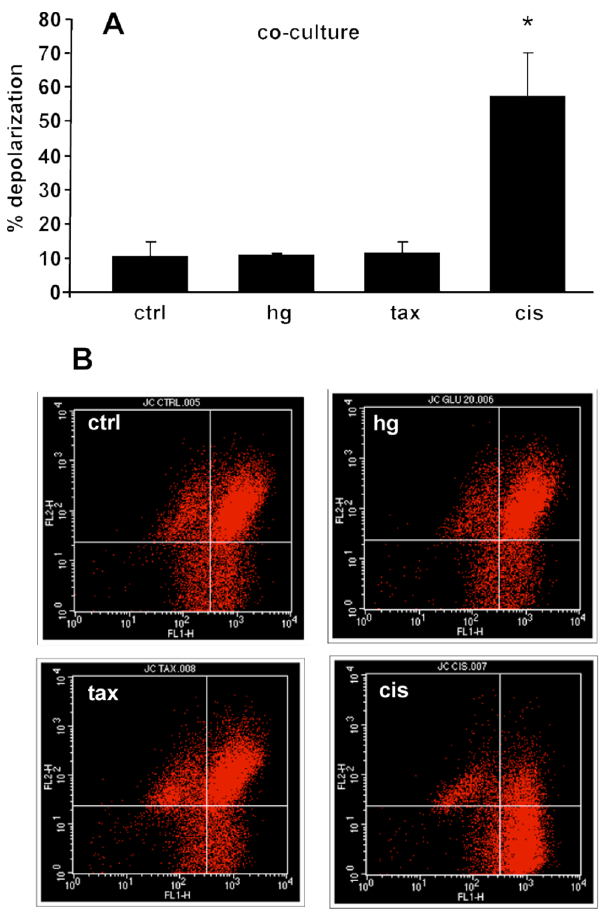
Figure 3. Hyperglycaemia did not affect mitochondrial mem- brane potential. (A) JC-1 fluorescence emission measurements showed a reduction in red-to-green ratio in neurons exposed to cisplatin (cis) but not to hyperglycaemia (45 mM) nor paclitaxel (tax) ( n =4), *p , 0.05 vs ctrl. (B) Representative flow cytogram of mitochon- drial membrane potential in co-cultures using JC-1. The shift of JC-1 fluorescence from red (FL2) to green (FL1) indicates a collapse of mitochondrial membrane